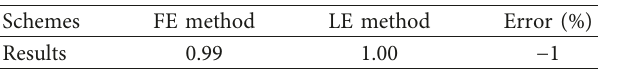
Figure 5: Stress distribution on the sliding surface. (a) Normal stress. (b) Shear stress. Table 4: Calculation results and error of two methods.